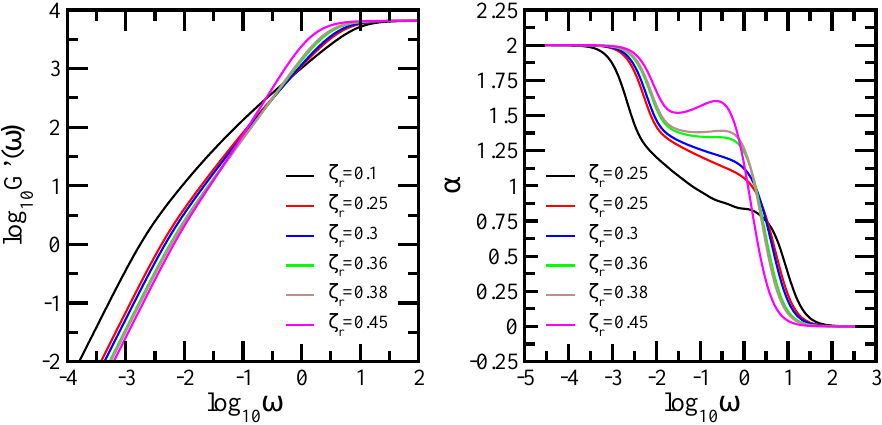
Figure 11. Left-hand side panel: Storage modulus G (cid:48) ( ω ) , displayed in dimensionless units for the dual Sierpinski gasket with size N = 3 8 , and the hydrodynamic interaction strength ζ r = 0.1, 0.25, 0.3, 0.36, 0.38, and 0.45. For guidance, the dashed black line indicates slope 2 and the red dashed line indicates slope 0. Right-hand side panel: Local slopes α of the curves of the left-hand side panel. Zimm